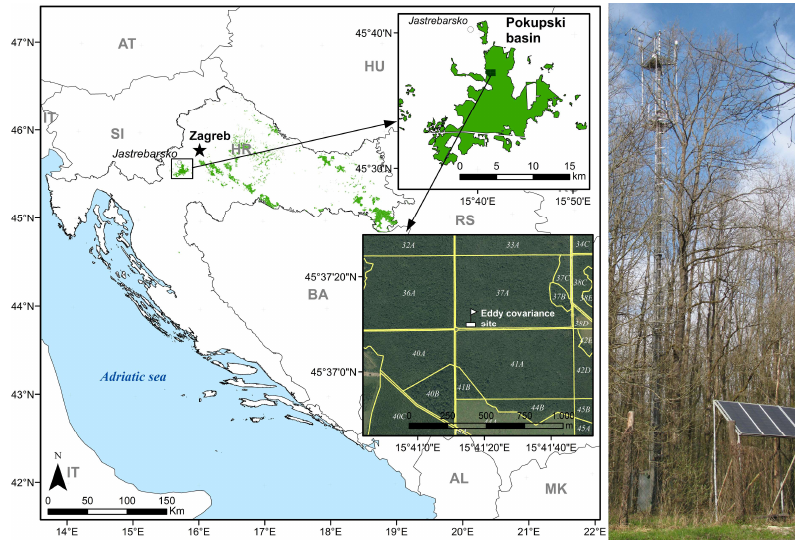
Figure 1. Map ( left ) shows a distribution of pedunculate oak stands in Croatia (marked in green) with the enlarged areas of the Pokupski basin and the location of the study site with the installed eddy covariance tower ( right ).